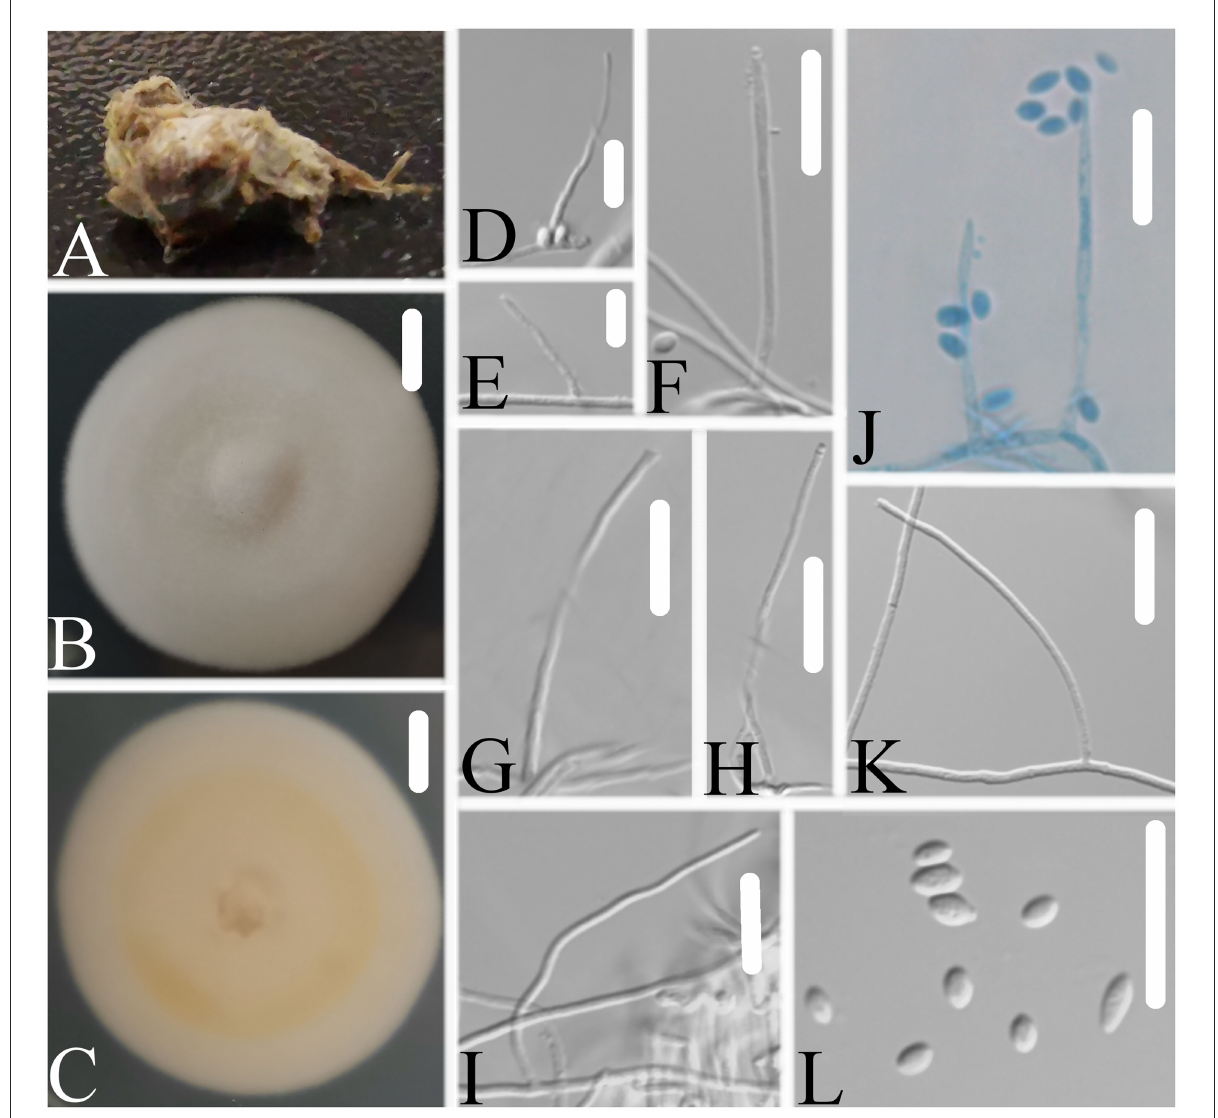
FIGURE7 Simplicillium larvatum (A) Infected larva (Lepidoptera); (B,C) PDA-containing culture plate showing the front (B) and reverse (C) sides of the colony; (D–L) solitary phialides and conidia. Scale bars: 10mm (B,C) and 10 µ m (D–L)